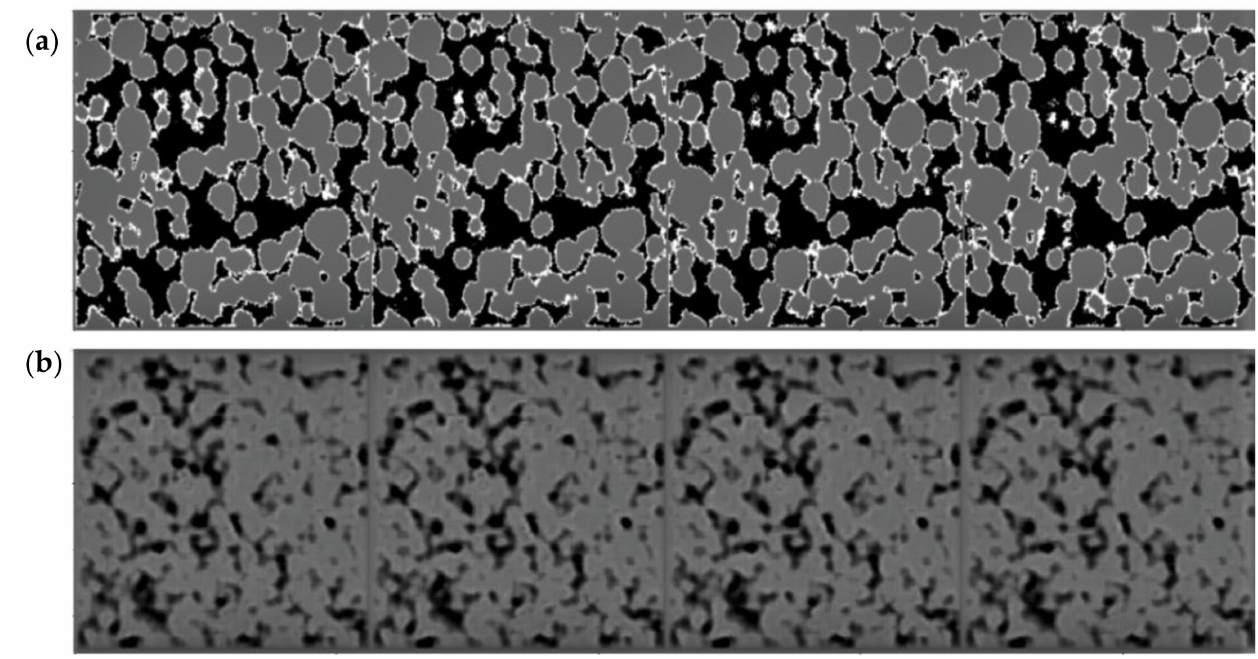
Figure 9. ( a ) A sample 3D calendered mini microstructure with size 4 × 224 × 224 ( b ) Reconstructed 3D microstructure from the 3-layer 3D CAE trained on the dataset created with a sliding window length of 4 and stride equal to the sliding window